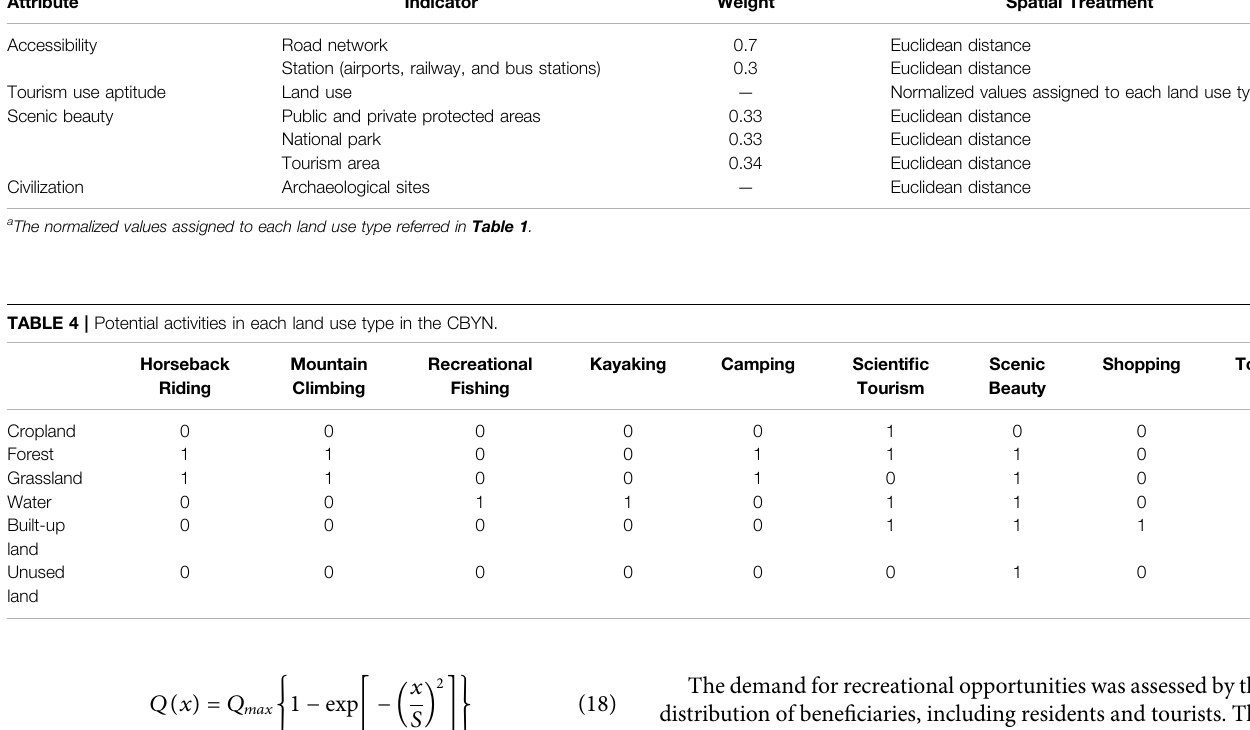
TABLE 3 | Attributes, variables, and weights used to assess the supply of recreational opportunities. Attribute